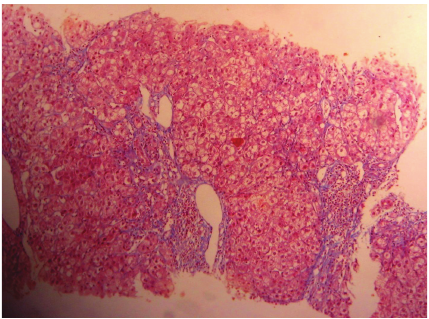
Figure 2: Histology: fibrous portal expansion with short septa. (TRI